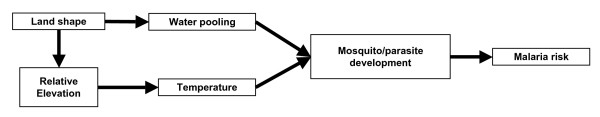
Theoretical relationship between elevation, land-shape, and malaria. Proposed relationship between the shape of the land, relative elevation, and malaria risk. The relationship between household elevation and malaria risk is confounded by the local shape of the land.